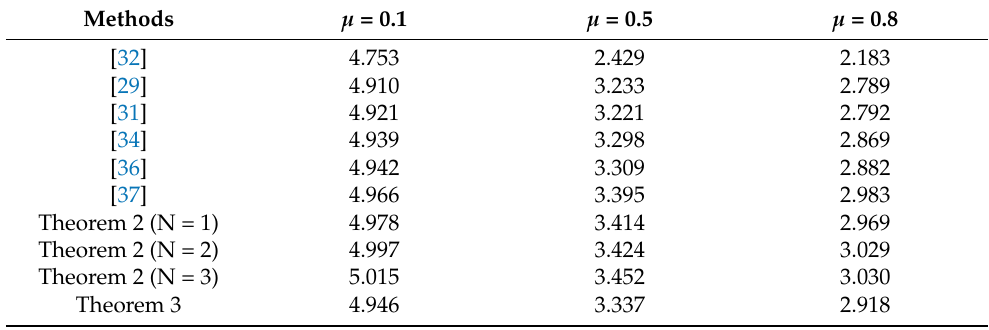
Table 1. Maximum allowable upper bounds of (cid:101) h for different µ .